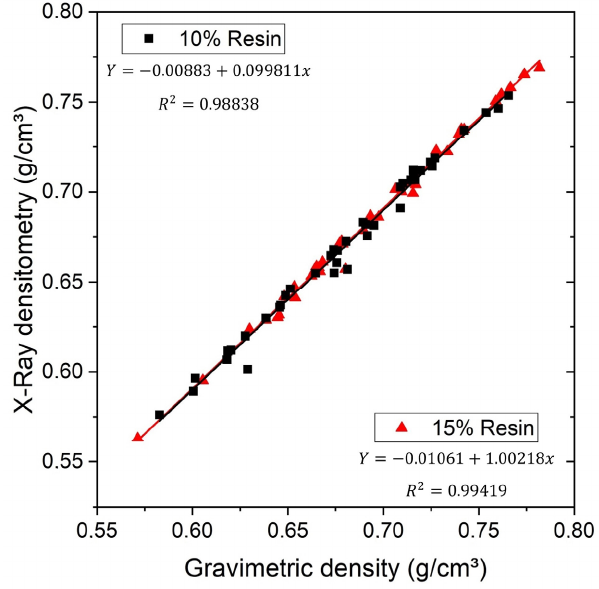
Figure 6. Correlation between densities obtained by X-ray and gravimetry. Scanning Electron Microscopy